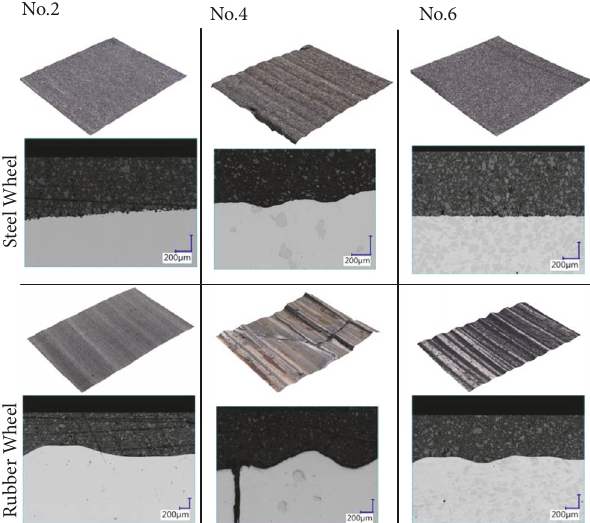
Figure 7: Real colour surface scans and cross section microscopy images of three series, tested with steel and rubber wheel, show the varying roughness caused by the different wear mechanism.